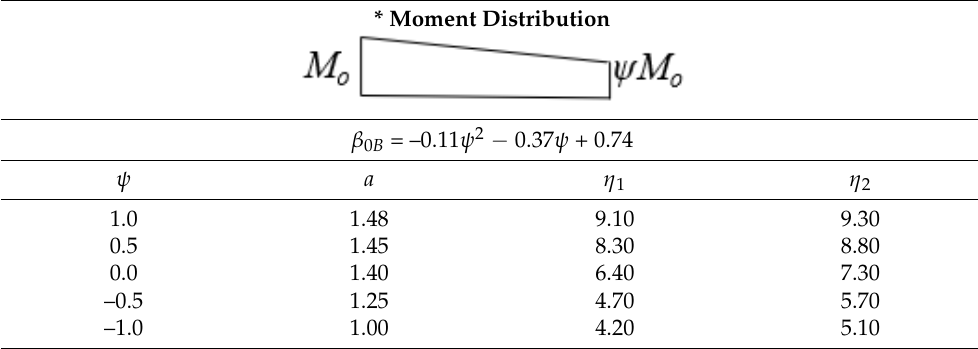
Table 5. Approximate determination of the elastic critical moment for members with end moments. Adapted from Hanswille et al. [117]. * Moment Distribution